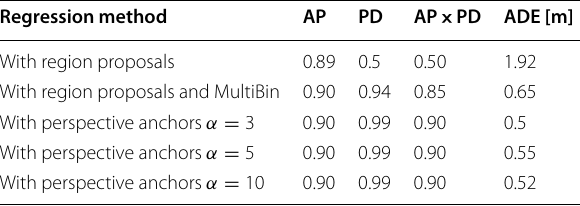
Table 3 Average precision (AP) over foreground